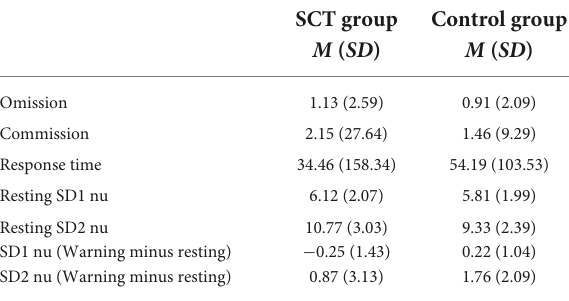
TABLE 4 Mean and standard deviation of HRV measures and CCPT measures in the SCT and Control groups.